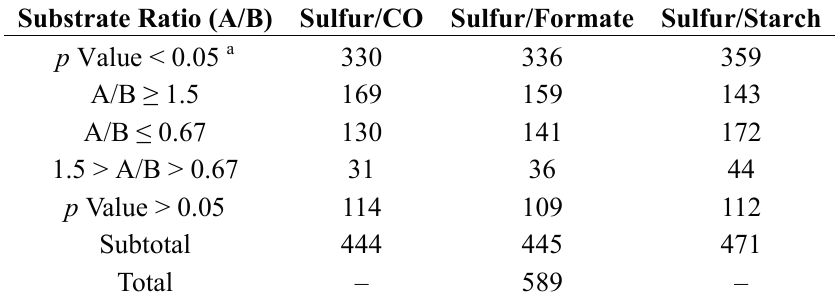
Table 1. Summary of quantitative proteomic analysis of Thermococcus onnurineus